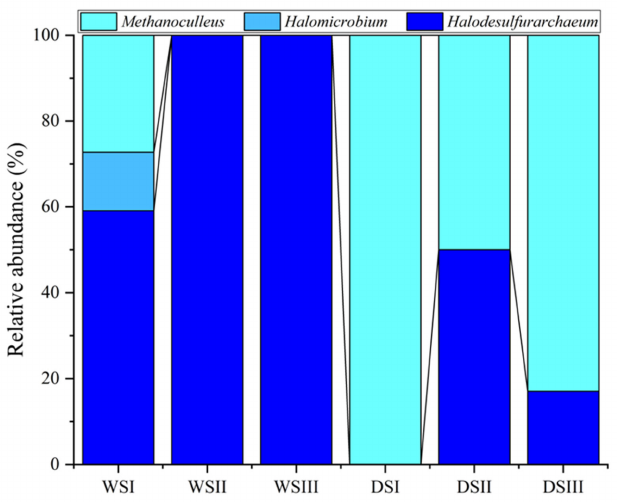
Figure 8. Archaeal taxonomic composition at genus level observed in salt samples. WS , white salt; DS , dark